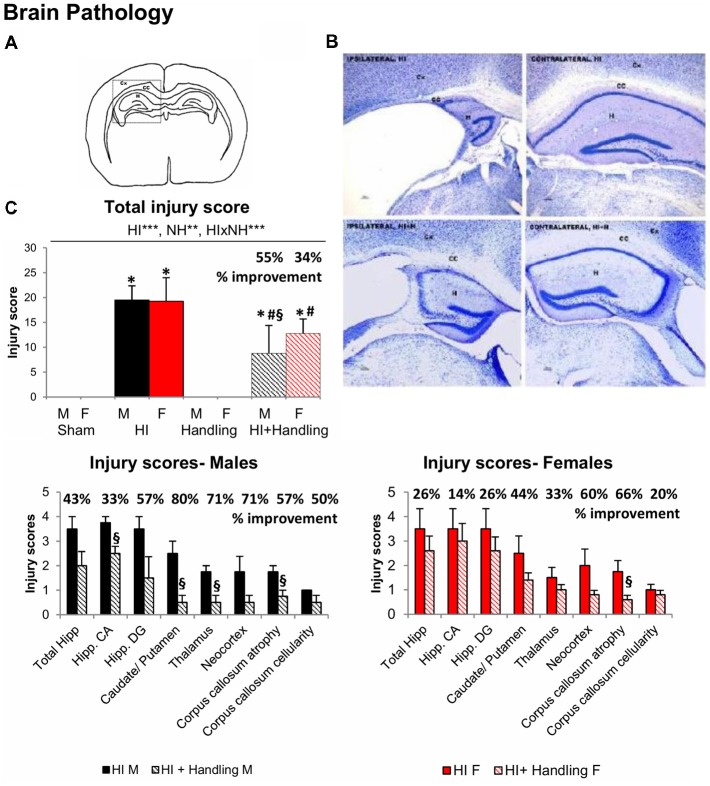
Neuropathological analysis after hypoxic/ischemic (HI). (A) Drawing modified in Adobe Photoshop CS showing brain areas analyzed for quantification of brain damage in the ipsilateral side. CX, cortex; CC, corpus callosum; H, hippocampus. (B) Nissl staining showing HI effects on the cortex, hippocampus and CC of the contralateral (right side of the panel) and ipsilateral (left side of the panel) hemisphere 90 days after hypoxia. (C) Graphs show the changes in the total injury score along with the injury score in different regions analyzed. HI males and females presented higher injury scores than sham and HI + NH mice when we analyzed total injury score, the last ones were also different from sham. When we measured the injury scores in the different brain regions, we observed that HI + NH males were different from HI in most regions; however, in females, the significant differences only appeared when we measured the CC atrophy. Results are presented as mean ± SEM. Statistics: repeated measures analyses of variance (RMA), two-way ANOVA: “HI” Hypoxia effect; “NH” handling effect; “S” sex effect; “A” age effect *P < 0.05, **P < 0.01, and ***P < 0.001. Student t-test. *P < 0.05 vs. sham of the same sex; #P < 0.05 vs. handling of the same sex; §P < 0.05 vs. hypoxia of the same sex.